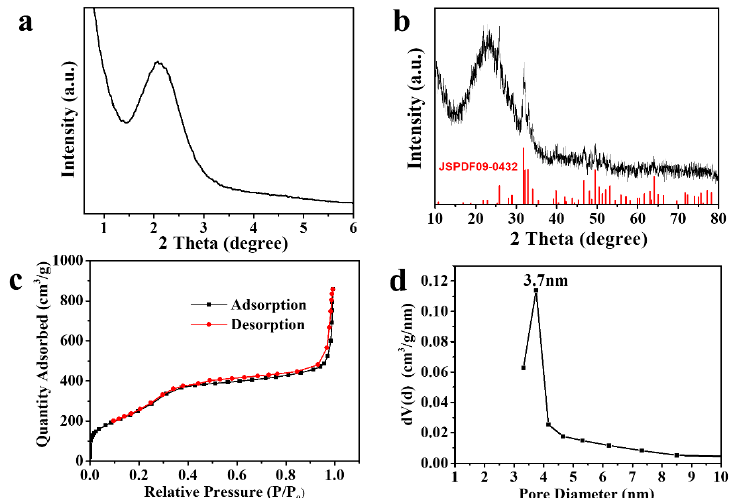
Figure 5. ( a ) Small-angle XRD (SAXRD) pattern, ( b ) WAXRD pattern, ( c ) nitrogen adsorption desorption isotherms, ( d ) pore size distribution diagrams of MSCNs.